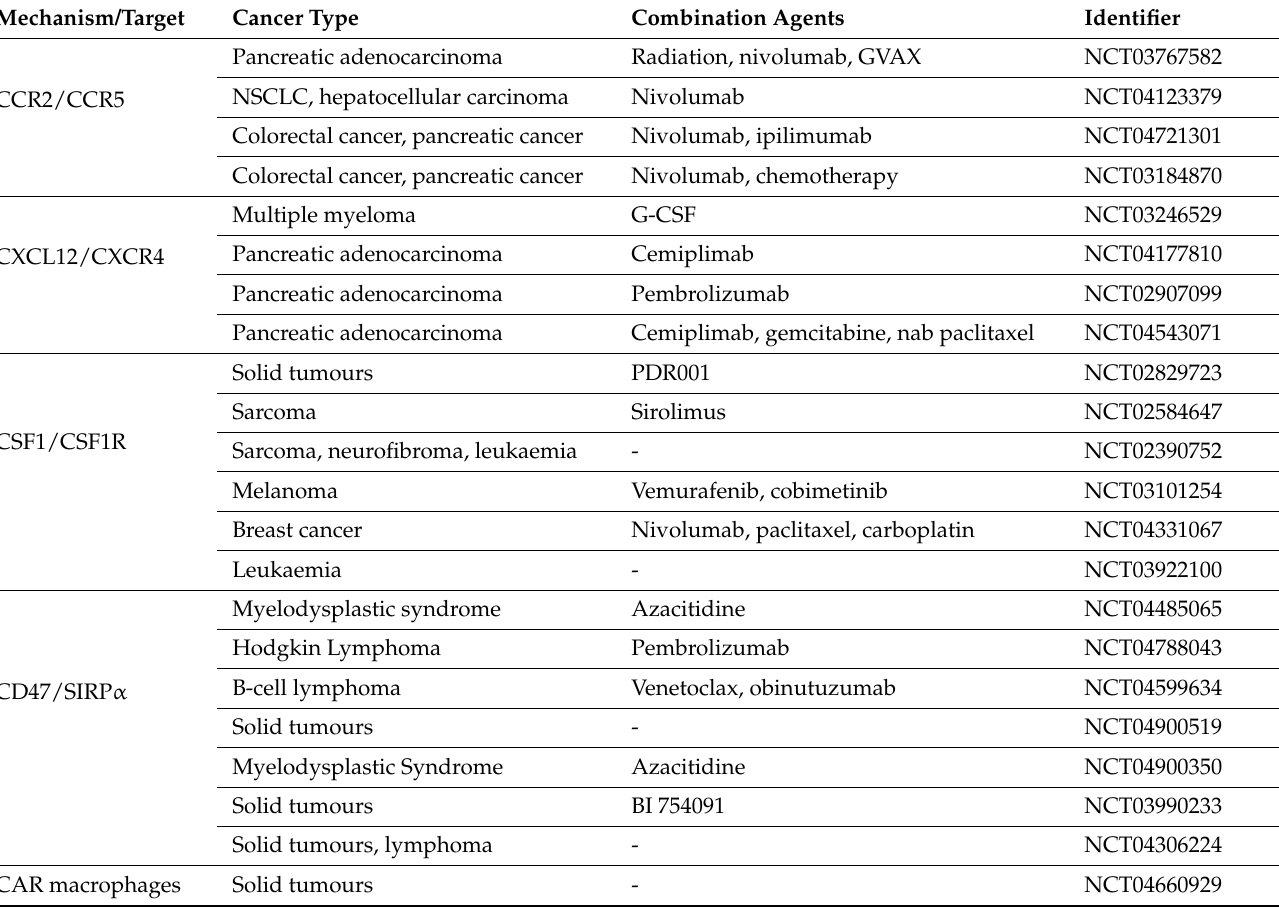
Table 1. Selected ongoing clinical trials evaluating major macrophage-targeting